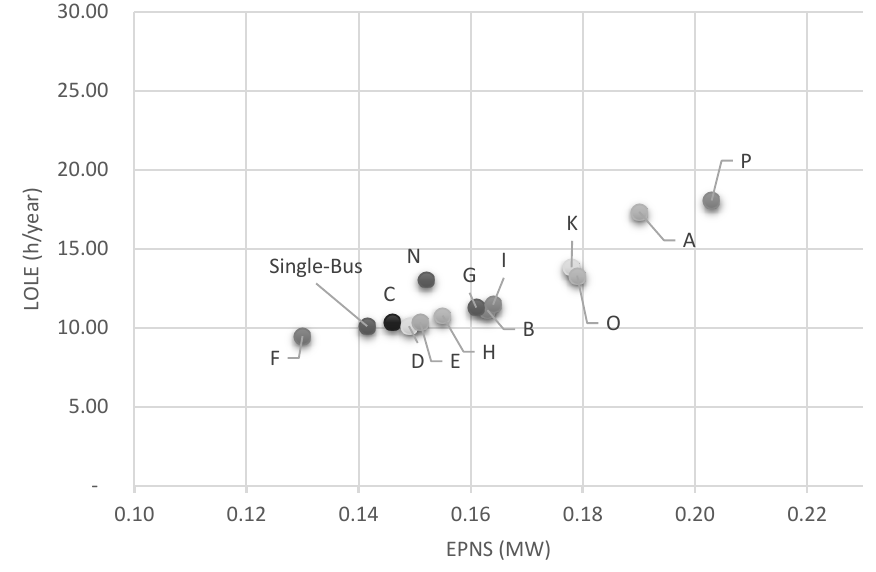
Figure 3. Results of Single Bus and Composite Analysis.